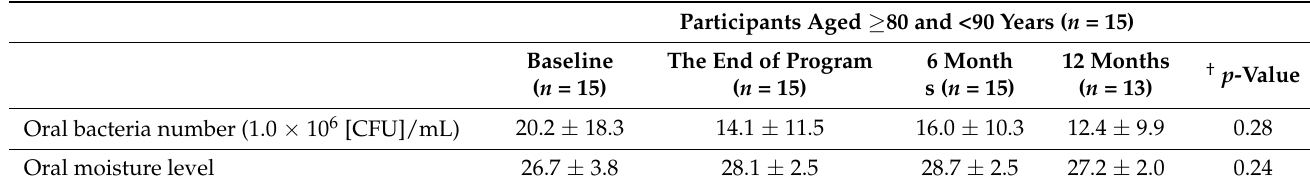
Table 7. Changes in oral bacterial numbers and moisture levels in participants aged ≥ 80 and <90